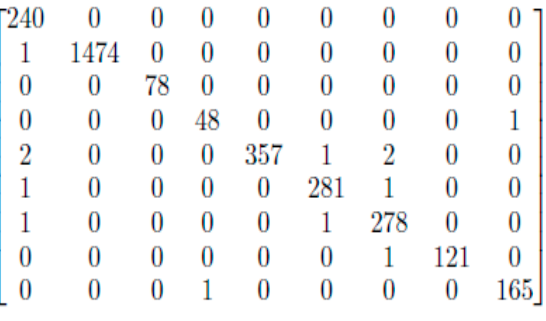
Figure 5. Confusion Matrix Figure 5. Confusion